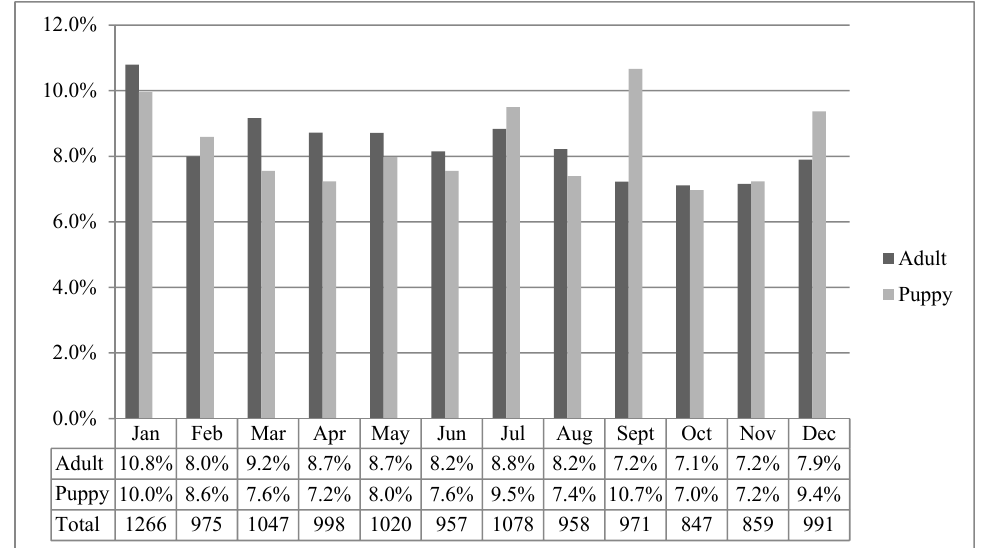
Figure 3. Numbers of admissions to RSPCA-QLD shelters in 2014 by month, and percentages of annual admissions by month within each of adult dogs ( n = 8883) and puppies ( n = 3084). Table 5. Numbers and percentages of the annual admissions to RSPCA-QLD shelters by month in 2014 within each of adult dogs and puppies. p -values compare the observed frequency in each month with the combined observed frequencies of the other categories within columns.